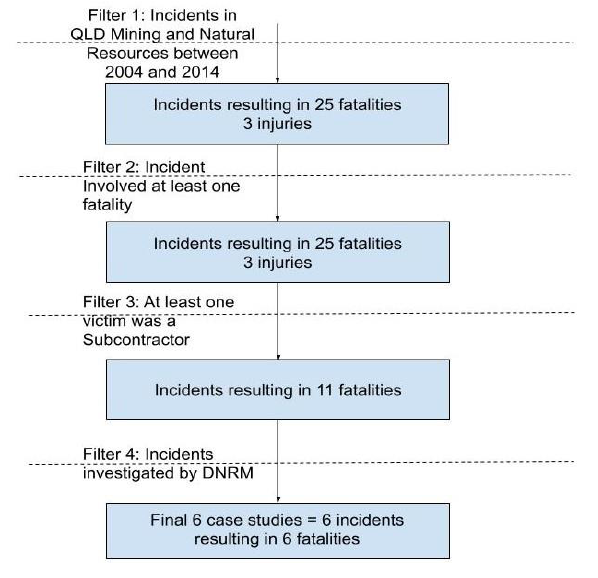
Figure 1. Incident selection